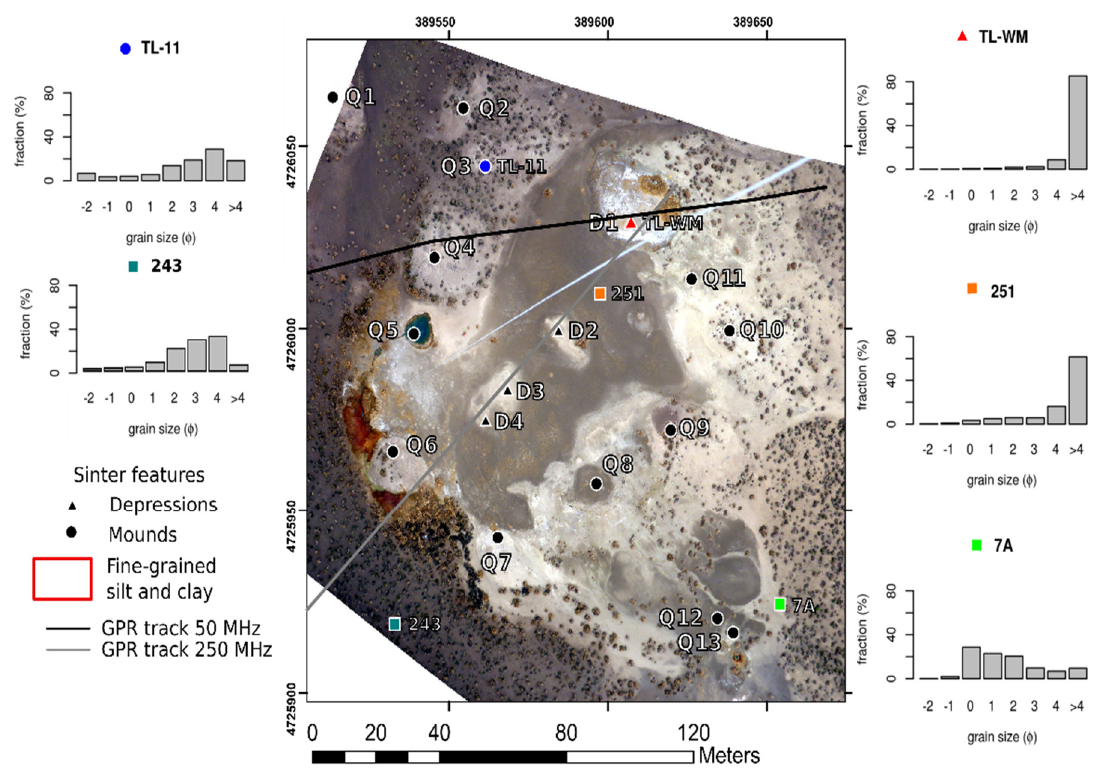
Figure 7. Area of sinter mounds and broad depressions. The aprons surrounding broad depressions are blanketed with silt and clay (gray area) that effervesces with HCl. White areas in the photo are exposed sinter or broken sinter gravel and sediment. Typical sediment outside of this area is poorly sorted coarse ‐ to fine ‐ grained sand (blue, teal, and green dots).